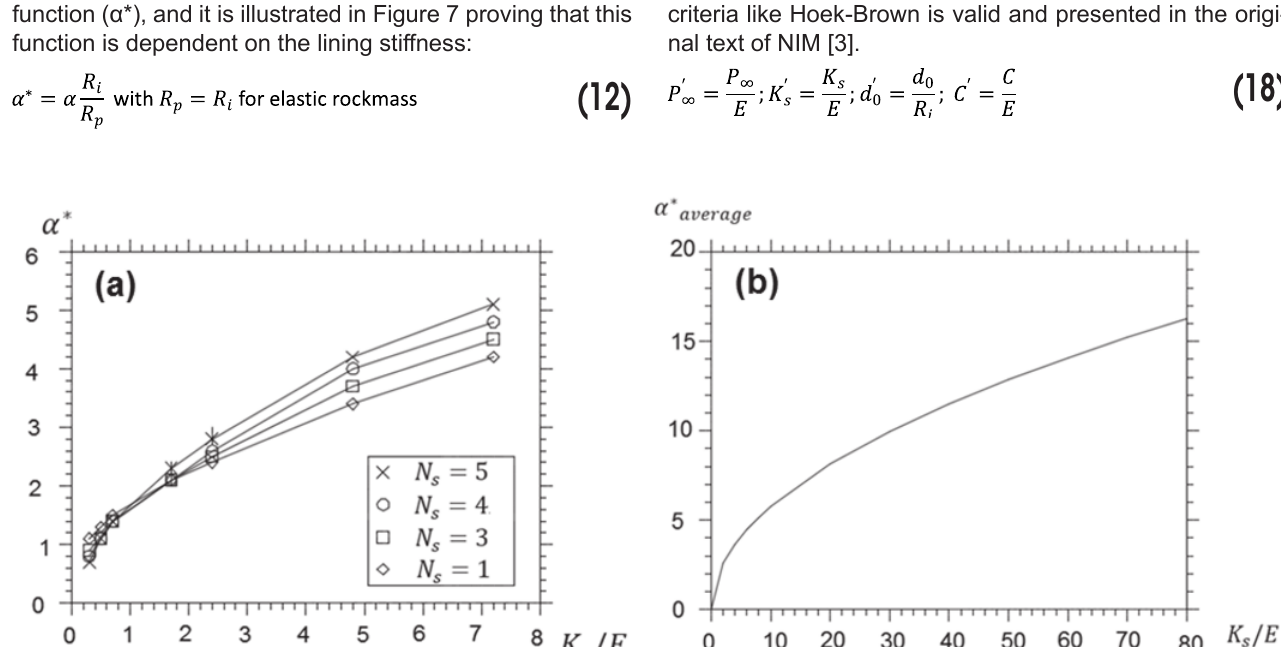
(a) Lining function α * for N (BERNAUD and ROUSSET, 1996